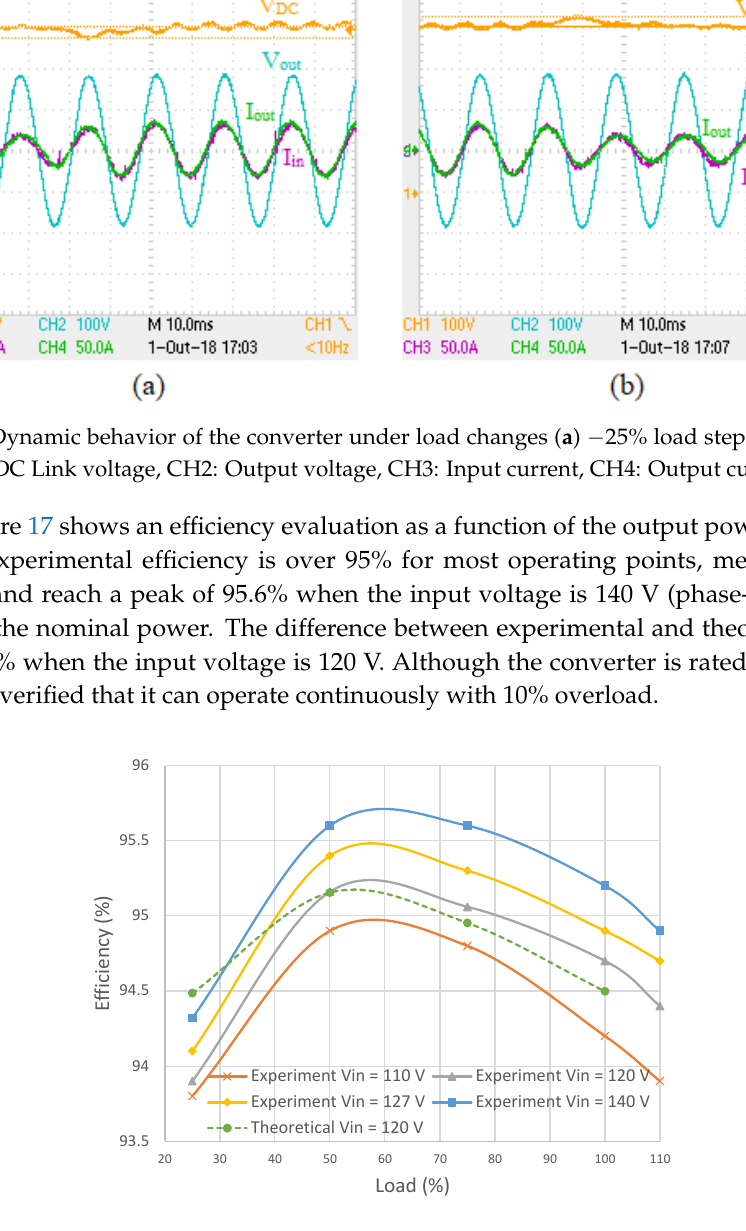
Figure 17. Efficiency measured with the power analyzer YOKOGAWA WT1800 for different input voltages and load